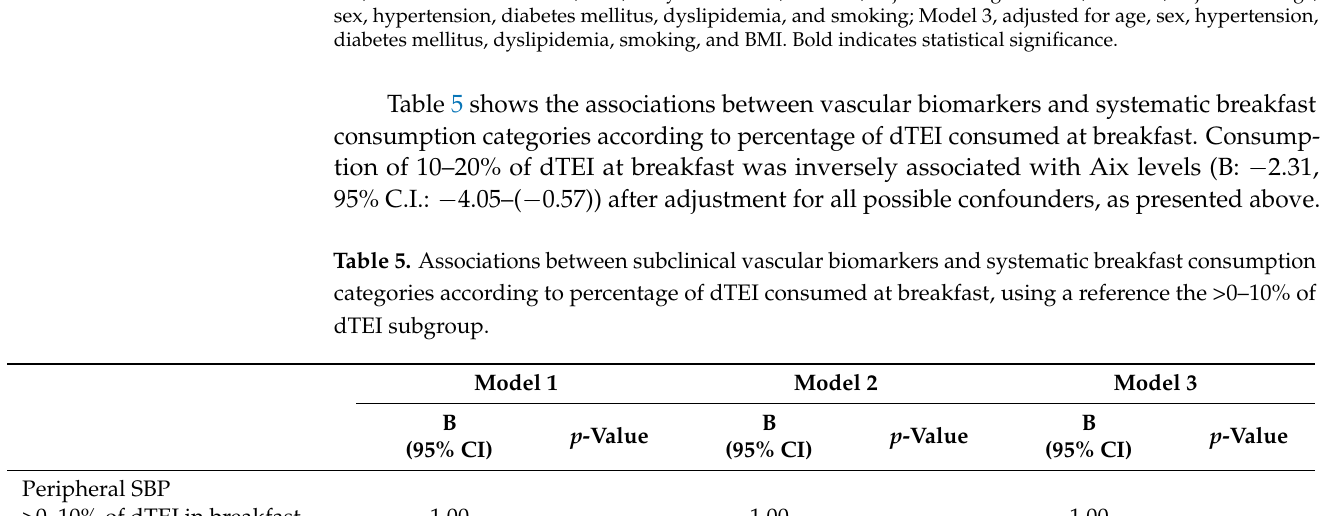
Table 5 shows the associations between vascular biomarkers and systematic breakfast consumption categories according to percentage of dTEI consumed at breakfast. Consump- tion of 10–20% of dTEI at breakfast was inversely associated with Aix levels (B: − 2.31,